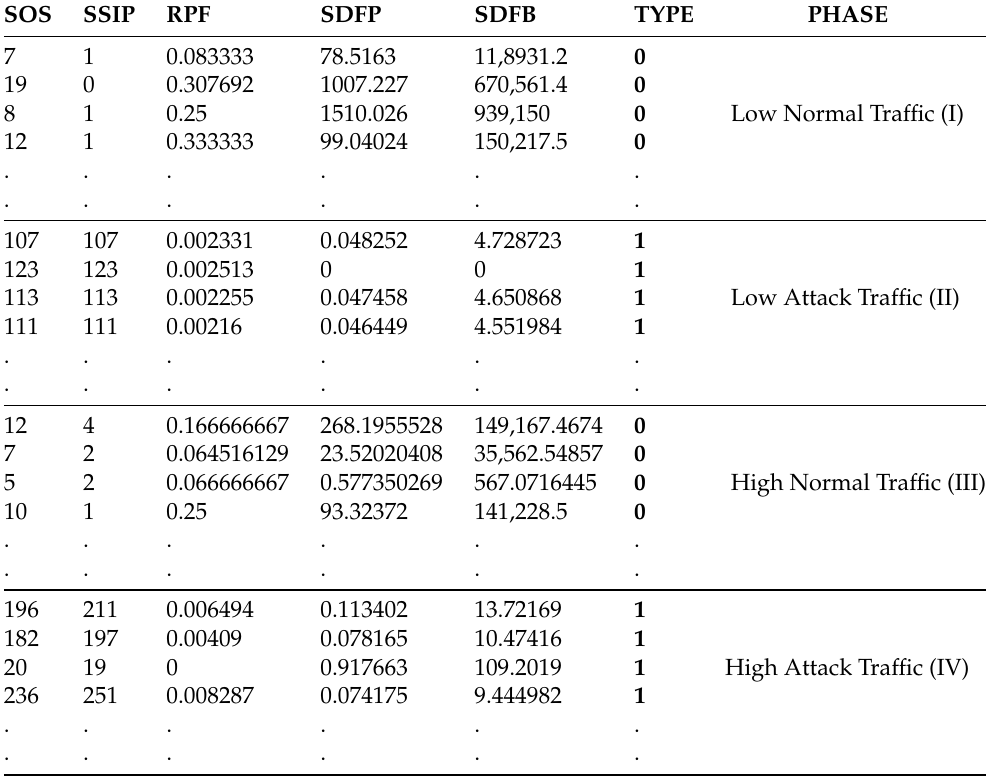
Table 2. Samples of the